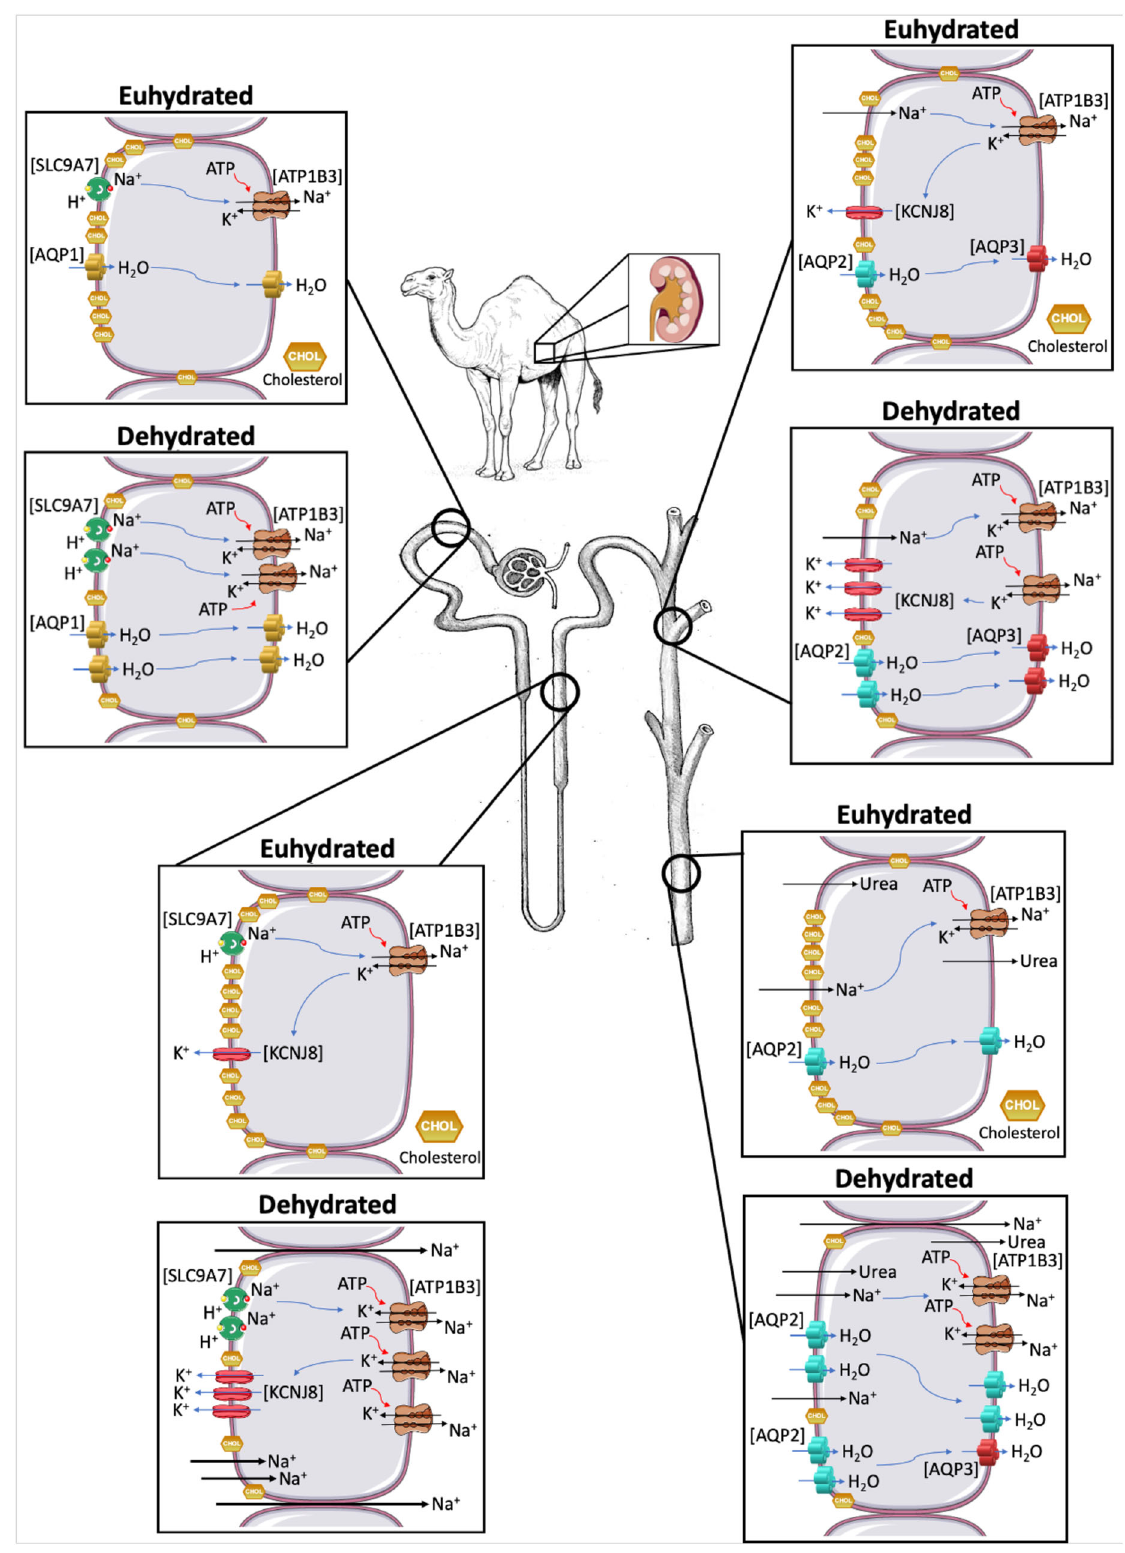
Fig. 8 Ion and water transport in the kidney. Schematic representation of the changes in transcellular movement of ions and water in the kidney between euhydrated and dehydrated dromedaries as a result of an increase in the abundance/activity of ion and water transporters facilitated by a partial depletion of cholesterol. Tubule lumen of the cell is on the left side of the cell diagrams whereas the interstitium is on the right side. All icons were freely available to download, modify and use in scienti fi c publications from SMART Servier Medical Art under the terms of the Creative Commons Attribution 4.0 International License (https://smart.servier.com/) and from REACTOME under the Creative Commons Attribution 3.0 Unported License (https://